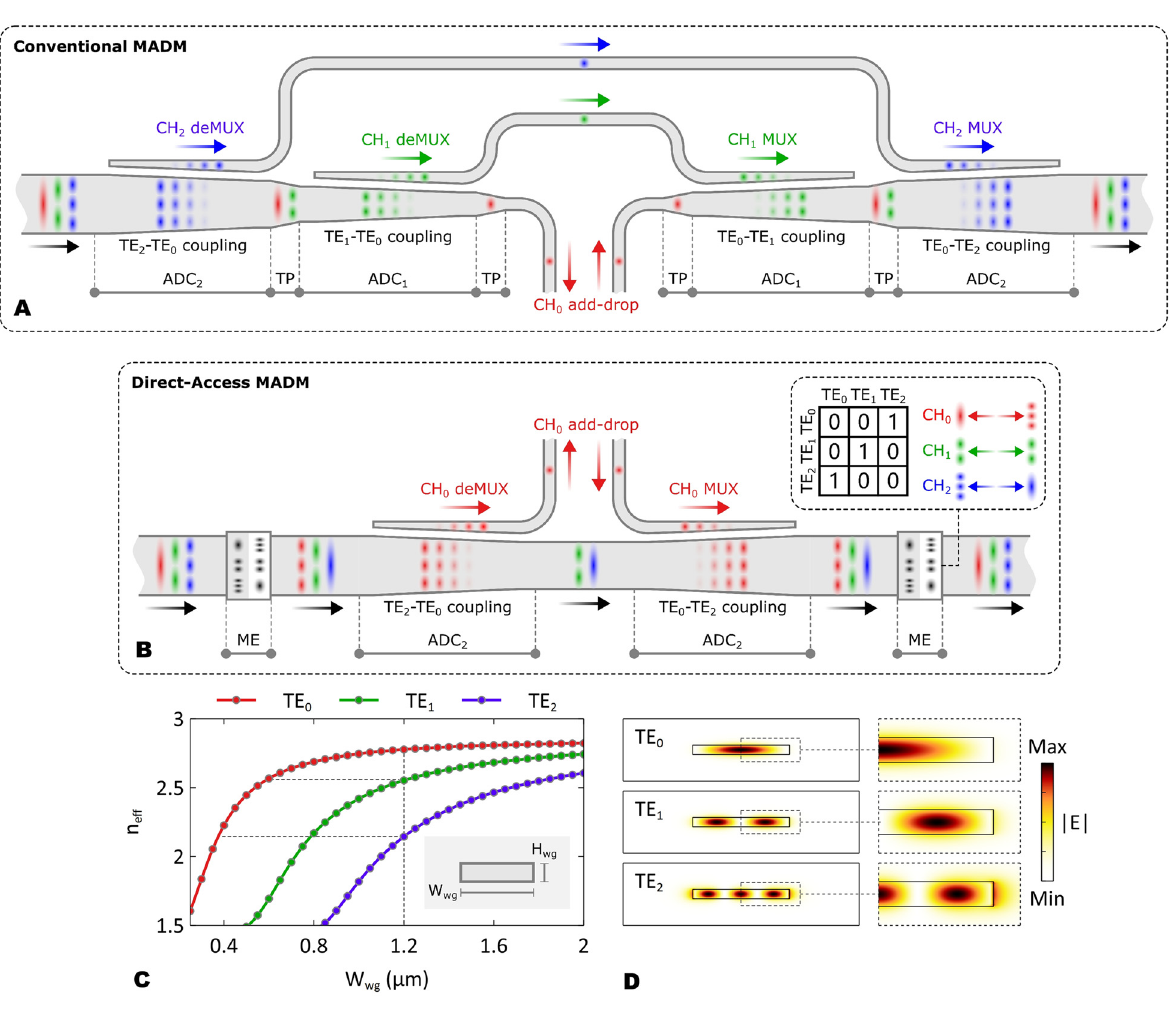
Figure 1: Illustration of “ direct-access ” conundrum in mode add-drop multiplexers (MADM). (A)TheschematicconfigurationofconventionalMADM.(B)Theschematicconfigurationofdirect-accessMADM.Theinsetillustratesthemode- swap process in a mode exchanger (ME). (C) The calculated effective indices ( n eff ) of TE 0 – 2 modes as functions of waveguide width ( W wg ). The inset shows a multi-mode waveguide cross-section. (D) The calculated fi eld pro fi les for TE 0 – 2 modes in a multi-mode waveguide with H wg =0.22 μ mand W wg =1.2 μ m.Thedashedboxesshowtheenlarged fi eldpro fi